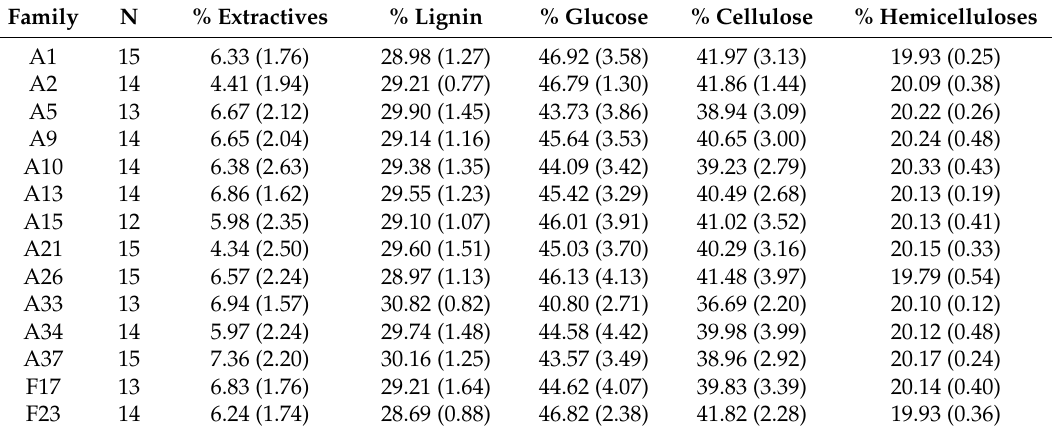
Table 6. Chemical traits of elite loblolly pine families on the Georgia